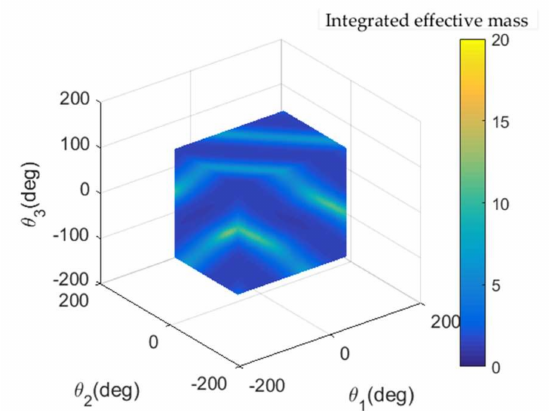
Figure 8. Relationship between integrated effective mass and capture configuration.